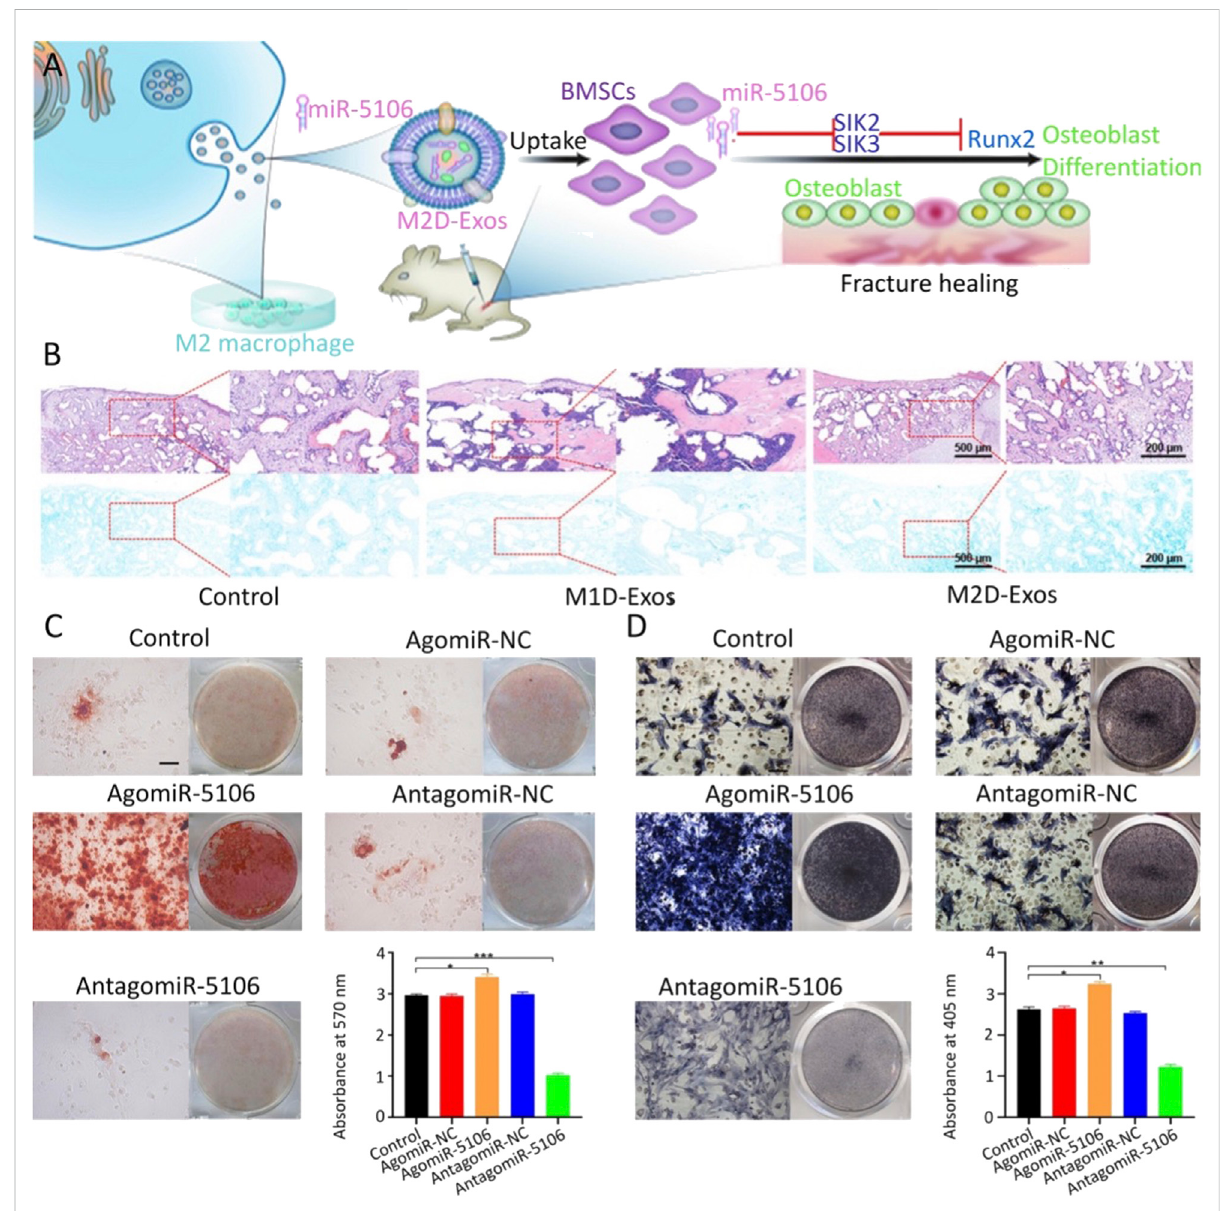
FIGURE 2 M2 macrophage-derived exosomes promote fracture healing by overexpression of miR-5106 (Xiong et al., 2020c). (A) Schematic diagram of M2 macrophage-derived exosomes (M2D-Exos) promoting fracture healing. (B) Bone tissue samples were stained with H&E/Alcian-blue staining after21daysoftreatmentwithPBS(control),M1macrophage-derivedexosomes(M1D-Exos),andM2D-Exos,respectively.ARSanditsquanti fi cation (C) andalkalinephosphatase stainingand itsquanti fi cation (D) ofBMSCstransfected withPBS,control agomirconstruct(agomir-NC), agomiR- 5106,controlantagomirconstruct(antagomir-NC),orantagomir-5106,respectively,for21days.Copyright2020.Reproducedwithpermissionfrom Springer